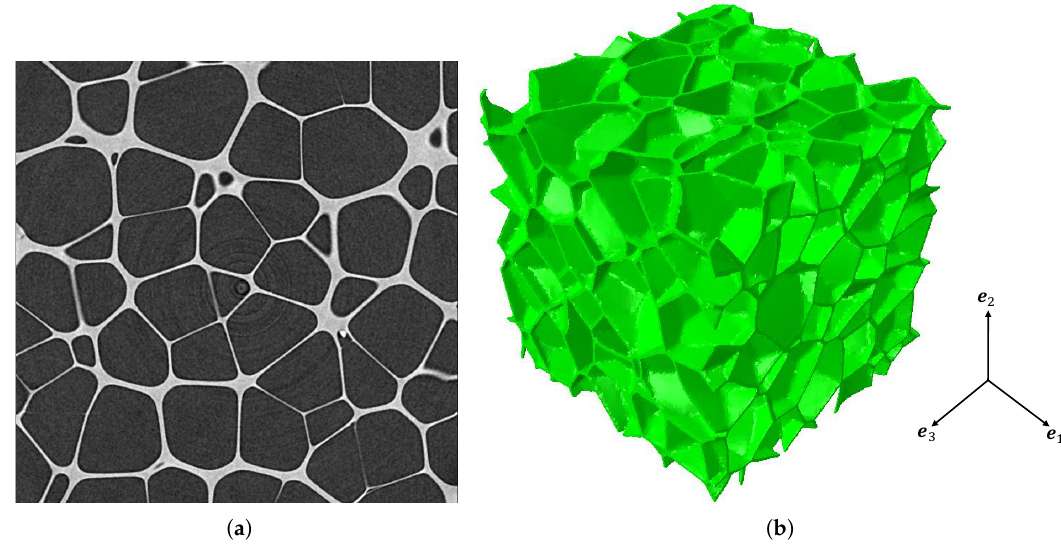
Figure 1. Tomographic data of the irregular closed-cell structure: ( a ) a tomography slice (400 × 400 px 2 ); ( b ) 3D rendering after reconstruction (400 × 400 × 400 px 3